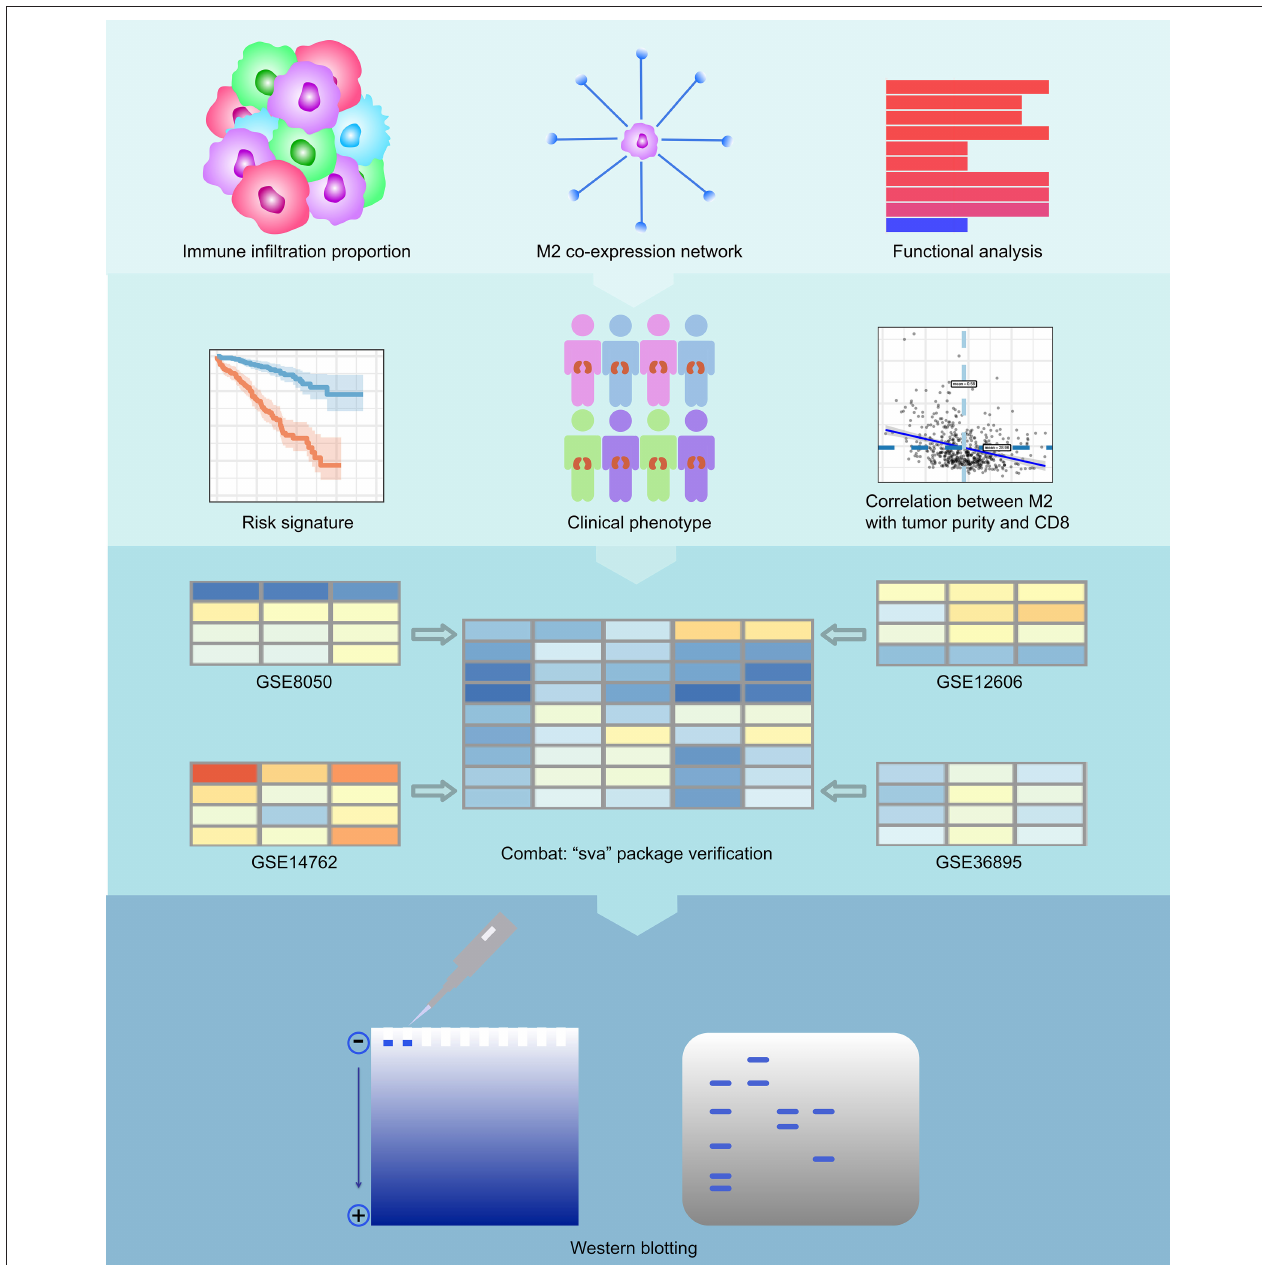
FIGURE 1 | Flowchart of the experimental design. We first calculated immune infiltration to determine the content of M2 macrophages in the immune microenvironment of RCC. Then, we constructed a co-expression network related to M2 macrophages of RCC and analyzed the enriched pathways in this network. We then calculated the survival analysis of these co-expressed genes. We constructed a COX regression prognostic model associated with the co-expression genes of M2 macrophages in RCC and performed a subgroup analysis of this model. We analyzed the relationship between key genes in the model and tumor purity